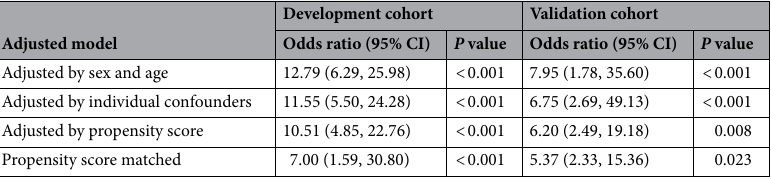
Table 3. Odds ratios associated with tICH expansion, and the presence of multihematoma fuzzy sign in patients with multiple hematomas (≥ 3 hematomas).